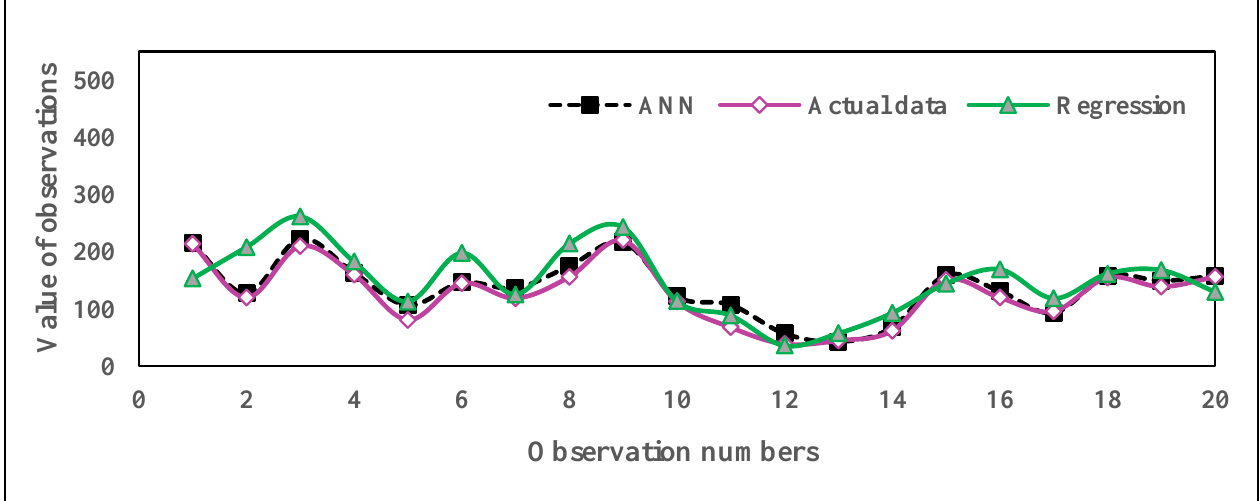
Figure 6. Predicted values of the fitted models with actual data